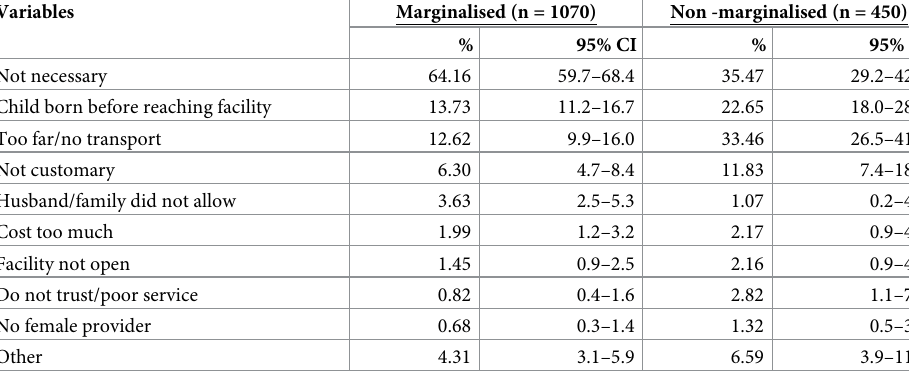
Table 6. Reasons for not delivering in the health facility among marginalised and non-marginalised women who delivered their last child at home.